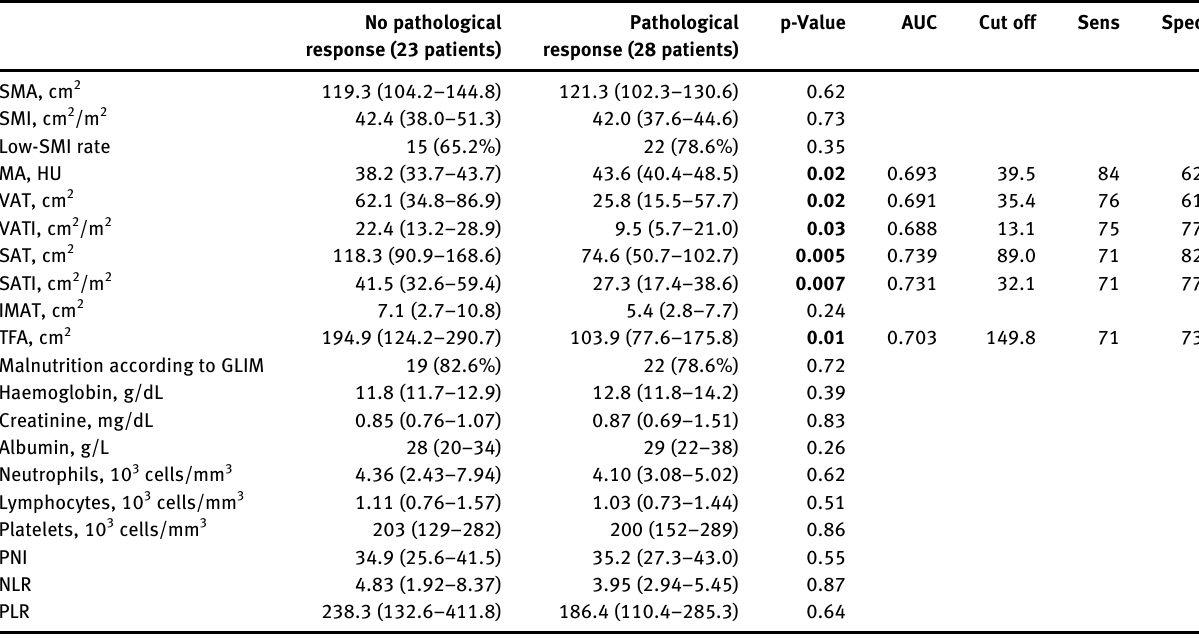
Table  : Laboratory and body composition data correlated to pathological response.